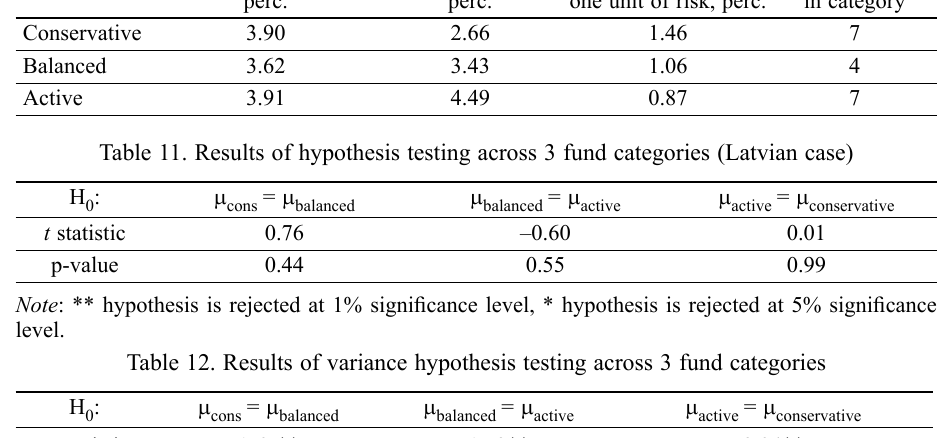
Table 10. Mean returns and standard deviations used in hypothesis testing Mean 12-month return, Fund category perc.